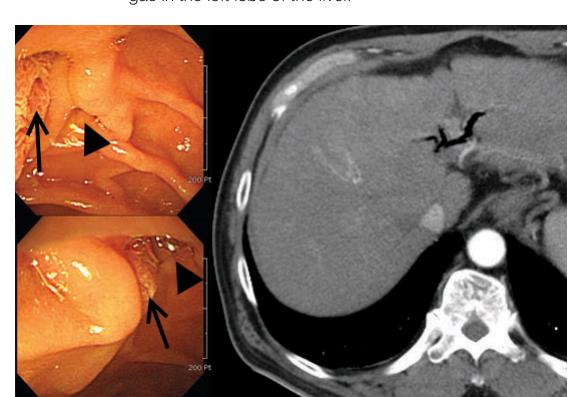
Figure 3. Gastrofiberscopic study revealed a small fistula (arrowhead) partially covered with intact duodenal mucosa near the ampulla (arrow) involved in the sphincterotomy. A bile- colored discharge and air were present in the suspected fistula. Computed tomography showed intrahepatic biliary gas in the left lobe of the